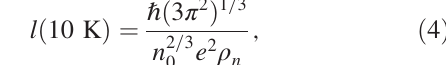
T , l and Δ =k obtained from fits of R c B c , and mean free path in the normal state, l ð 10 K Þ , were obtained from n